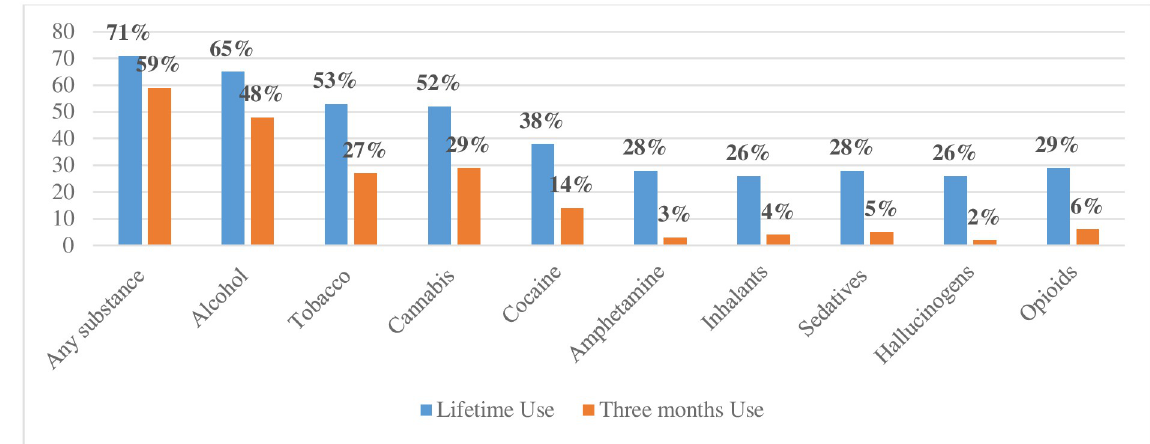
Fig 1. Lifetime and recent substance use among people experiencing homelessness, stratified by substance type (n = 305).